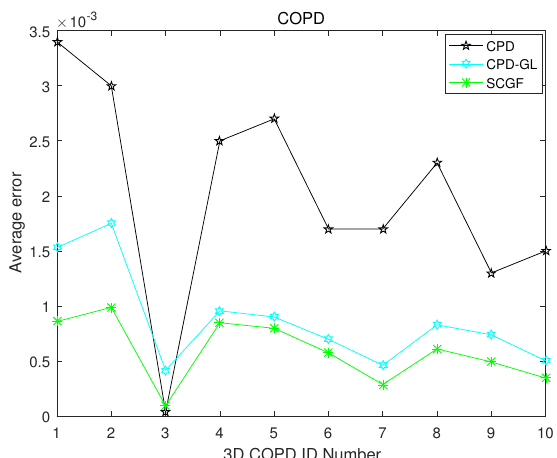
Figure 10. MSED achieved from the application of the under-comparison pair-wise registration algorithms on multiple point set groups generated by 3D COPD data (please see text for the details).